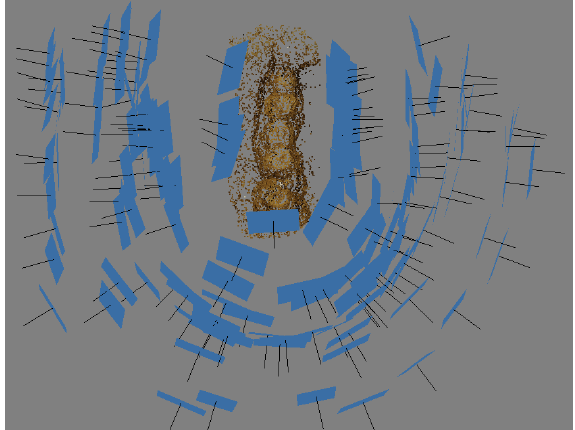
Figure 5. Sparse point cloud and imaging configuration (top view, Screenshot Agisoft PhotoScan)